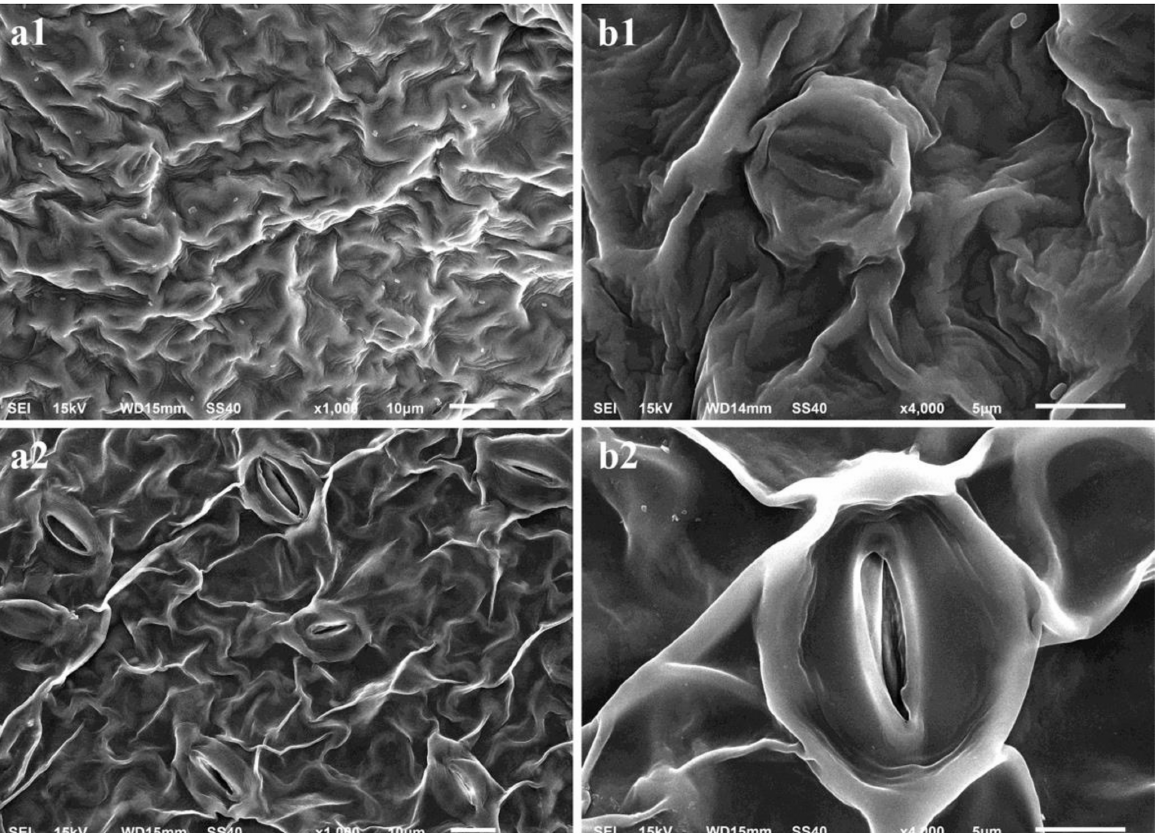
Figure 4. (1) Scanning electron microscopic examination of leaves from in vitro-propagated D. palmatus ; ( a1 ) abaxial leaf surface showing deep seated closed stomata; ( b1 ) not fully functional guard cells showing irregular stomatal opening and abnormal stomata. (2) SEM examination of a leaf taken from acclimatized regenerated plantlets of D. palmatus ; ( a2 ) abaxial leaf surface showing well-developed stomata; ( b2 ) open stomata with clear